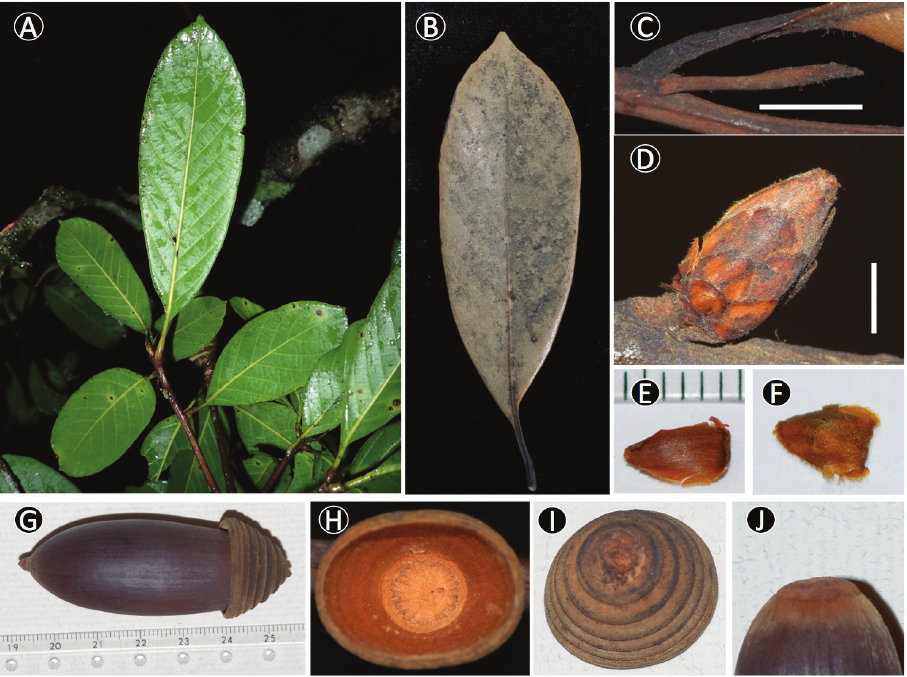
Figure 3. Quercus xuanlienensis Binh, Ngoc & Bon. A Leafy twig B Adaxial side of mature leaf C Stip- ules D Bud E, F Inside and outside of bud scale G Mature fruit H, I Inside and outside of cupule J Basal scar of the nut. Scale bars: C 5 mm D 3 mm. Materials from Binh et al. V6967